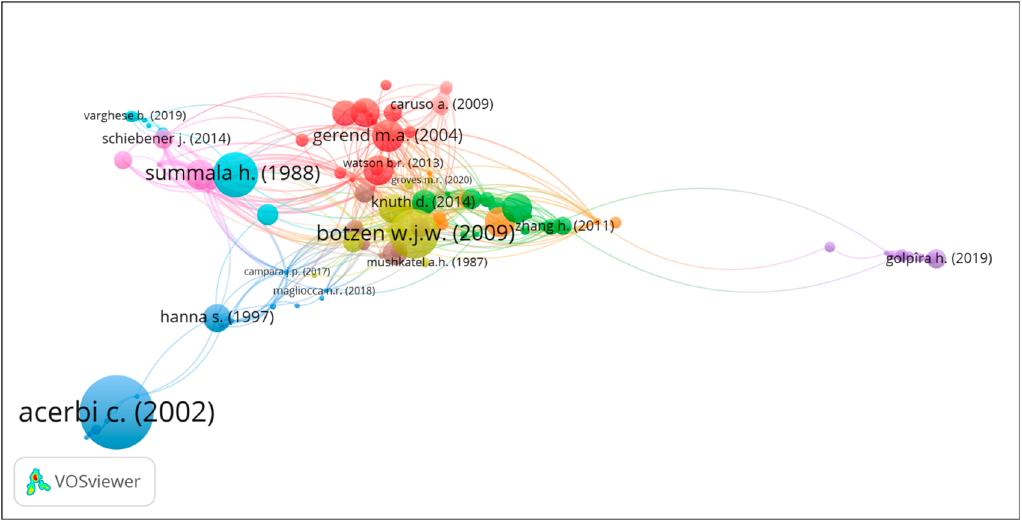
Figure 1. Visualisation Map of Top 20 Most Cited Documents on “Objective Risk” and “Subjective Risk”.